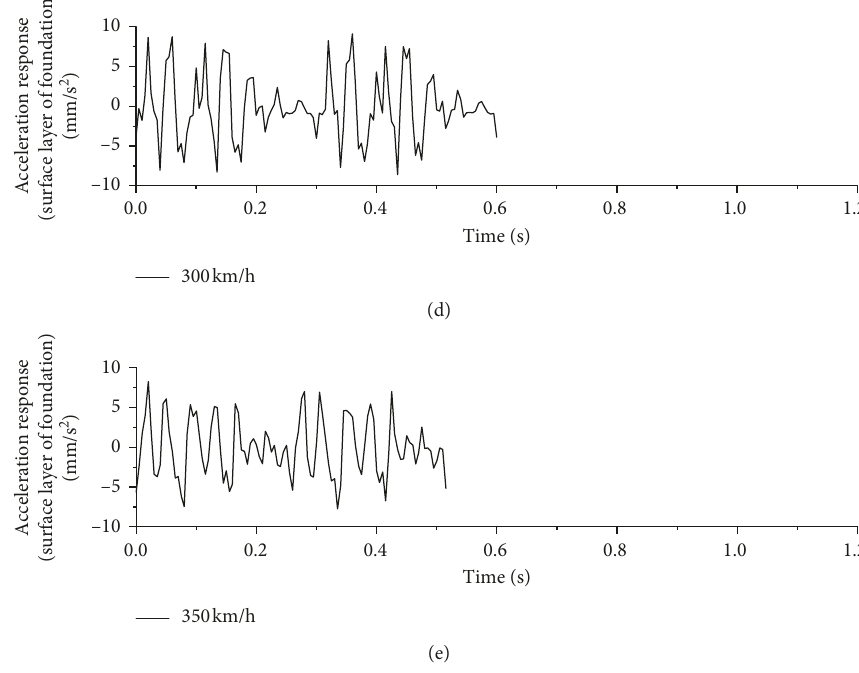
Figure 14: Acceleration under different speeds with respect to time.